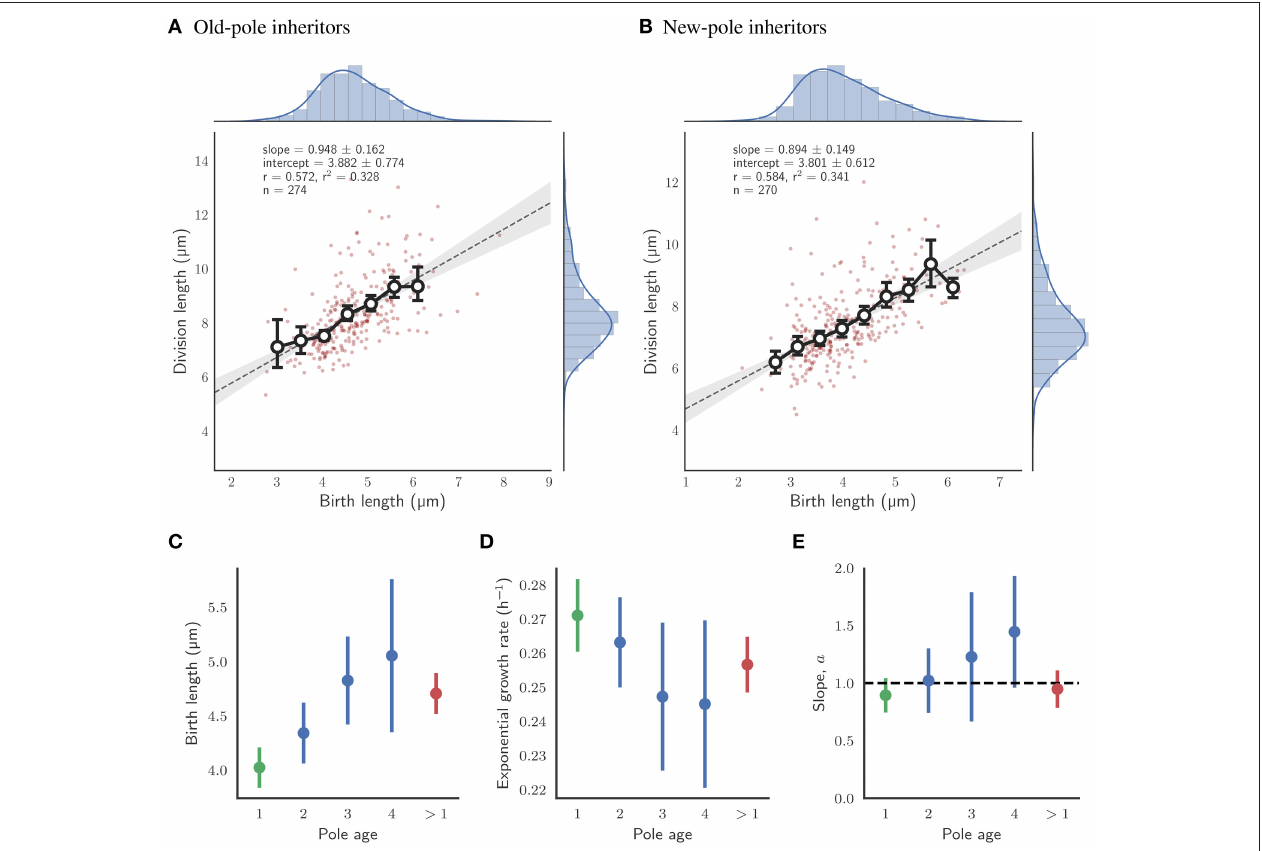
FIGURE 4 | Impact of pole age on the growth of single cells with glycerol as a sole carbon source. (A) Fit of division length against birth length for daughter cells which inherit the old-pole from their mother cell. Colors and legends as for Figure 2 . (B) Fit of division length against birth length for daughter cells which inherit the new-pole from their mother cell. Colors and legends as for Figure 2 . (C) Mean birth length for cells by age of the inherited pole in number of generations. (D) Mean exponential growth rate by age of the inherited pole. (E) Slope of the linear fit of birth length against division length for cells by age of the inherited pole. The black dashed line represents the case where cells act as perfect adders ( a = 1). (C–E) The error bars depict the 95% confidence intervals of each estimate. n -values were 99, 39, and 21 in order of generation number for old-pole cells with known age (shown in blue). Data for all new-pole inheritors (with an age of 1 generation; n = 270), and for all old-pole inheritors (with an age of more than 1 generation, including those without a precise age; n = 272) are shown in green and red respectively.